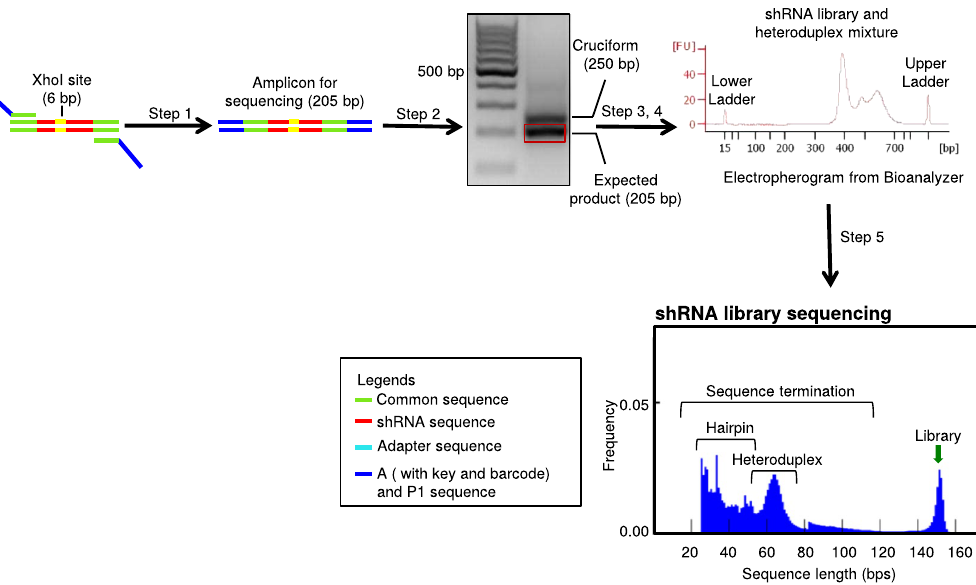
Figure 2. Steps involved in shRNA library sequencing. Workflow showing steps involved in sequencing shRNA library from the genomic DNA. Step1: PCR amplification of shRNA library from gDNA. Step 2: PCR purification of the amplified library. Step 3: Gel extraction of the 205 bp library amplicon. Step 4: Quality assessment of the library using a Bioanalyzer. Step 5: shRNA library sequencing using Ion Torrent platform. Representative agarose gel, electropherogram from the Bioanalyzer and read-length histogram from Ion Torrent are shown. The sequence length is plotted in the X-axis and the frequency is plotted in the Y-axis. The shRNA library is 152 bp, excluding the A and P1